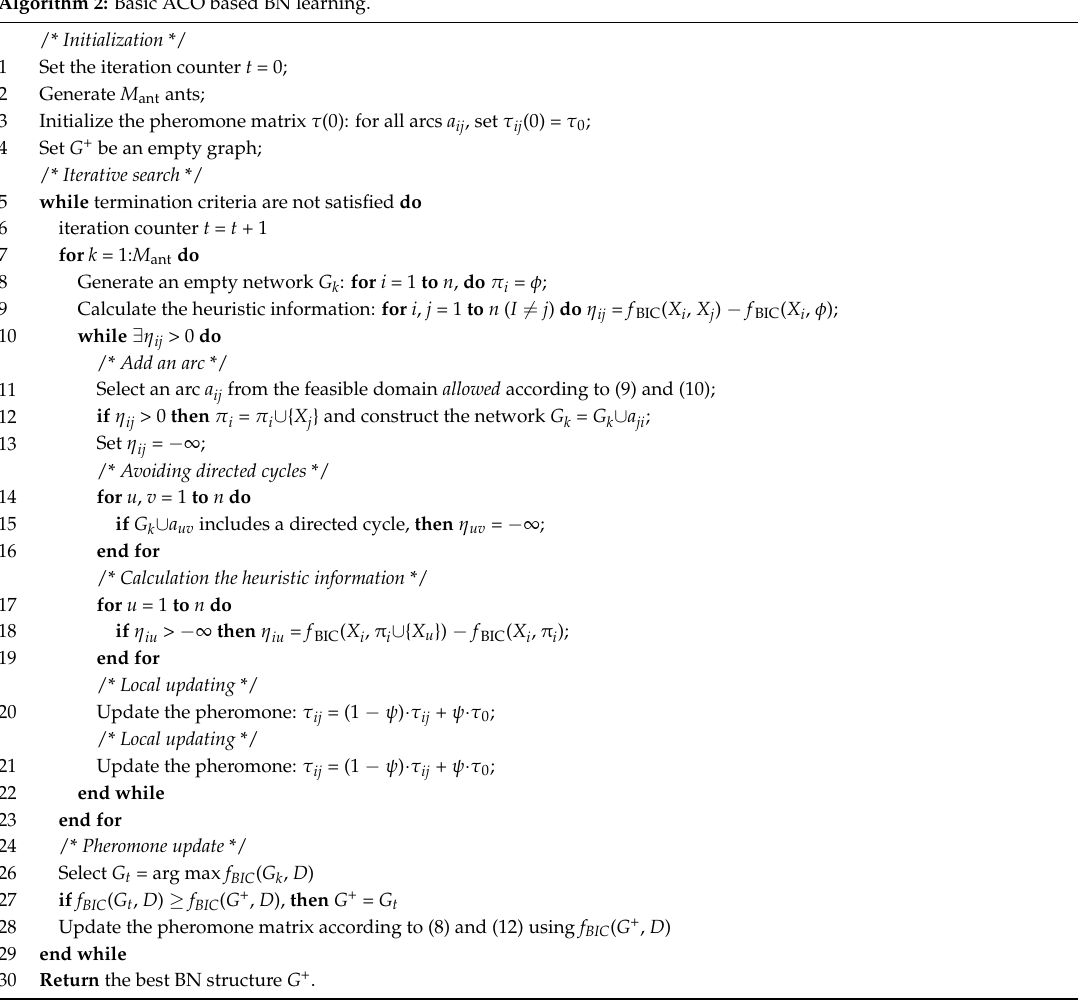
Algorithm 2: Basic ACO based BN learning.